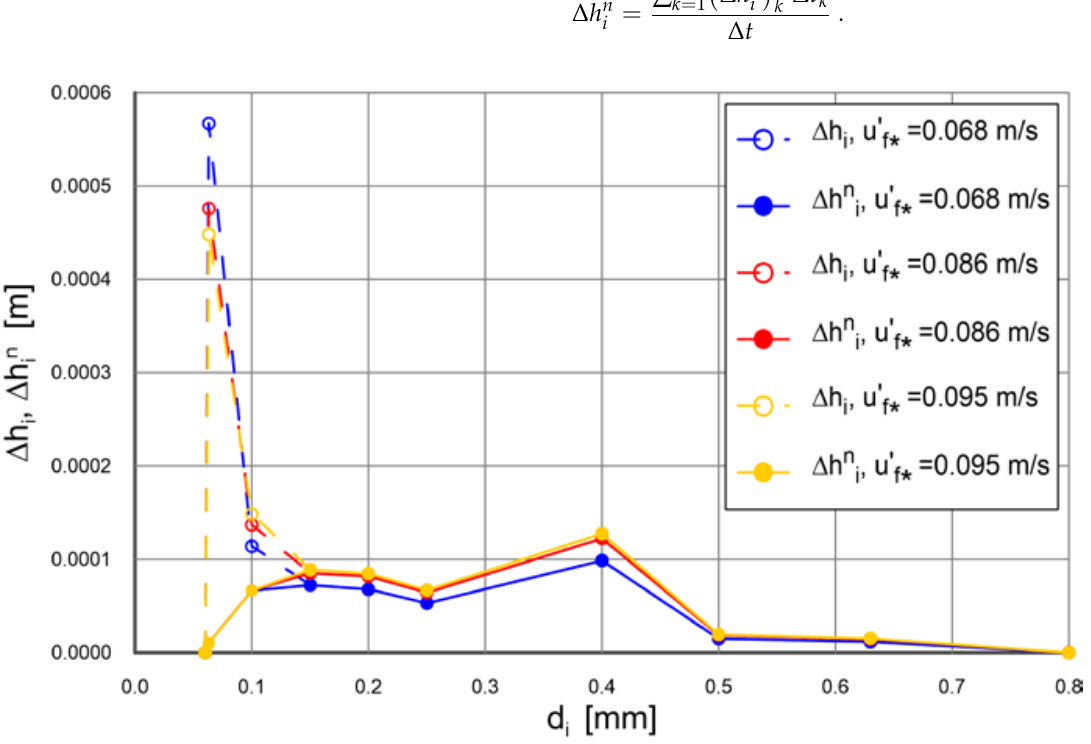
of the i- th sediment fraction caused by Figure 12. Model results of the erosion thickness Figure 12. Model results of the erosion thickness ∆ h i of the i -th sediment fraction caused by transport transport and the reduced thickness caused by due to limited availability of very fine q i and the reduced thickness ∆ h n caused by q n due to limited availability of very fine ∆ℎ 𝑖𝑖 i i fractions. 𝑖𝑖𝑛𝑛 𝑖𝑖𝑛𝑛 𝑞𝑞 𝑖𝑖 ∆ℎ 𝑞𝑞